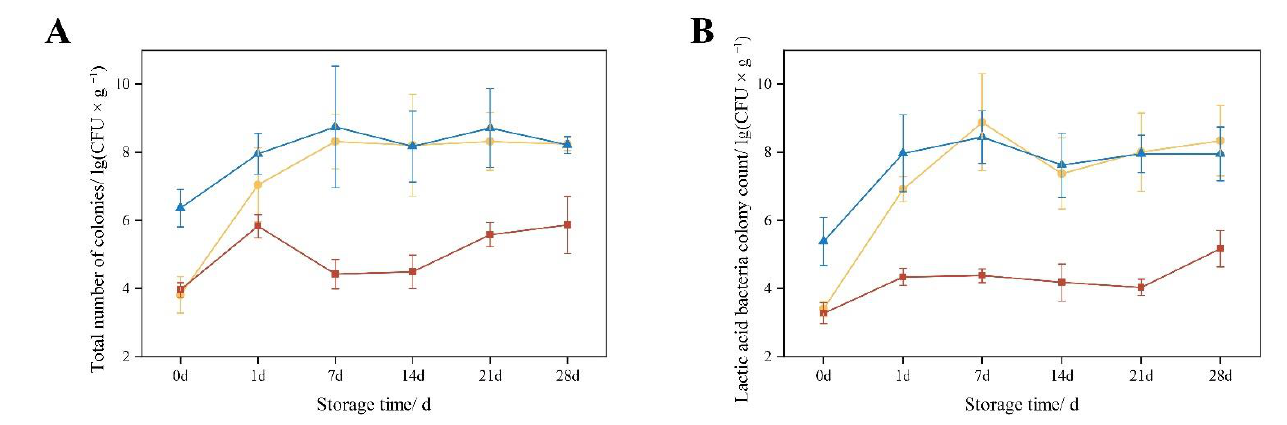
Figure 1. The changing trend of the total number of colonies and the number of lactic acid bacteria in lamb liver paste during the storage period. Note: yellow represents the natural fermentation group (NF); blue represents the starter fermentation group (SF); red represents the sterilization group (ST). ( A ) represents the change of the total colony number of the lamb liver paste with the storage time, and ( B ) represents the change of the lactic acid bacteria colony count of the lamb liver paste with the storage time.